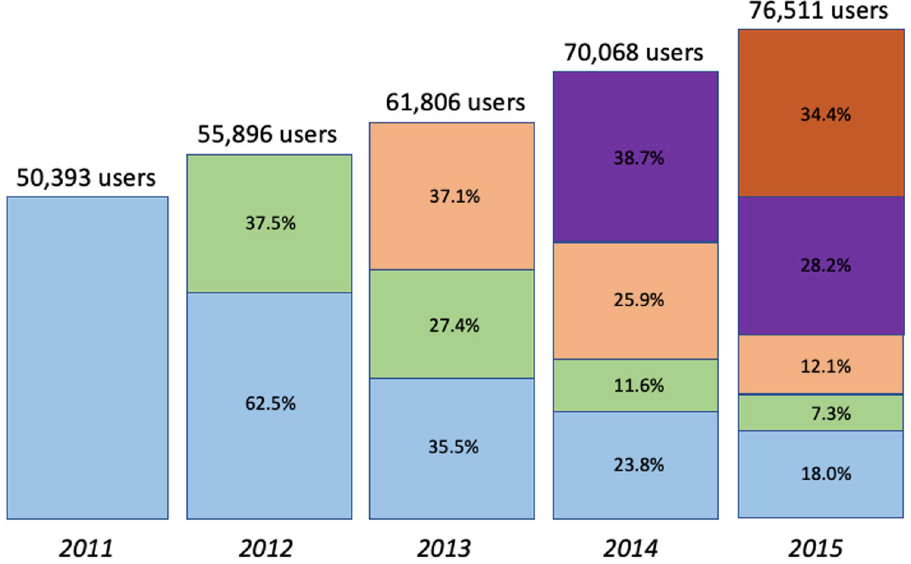
Fig 1. Progressive renewal of users over the years. For each year, the box height represents the total number of users and the colors the year users have entered the system. For example, in 2015, 34.4% of users are new to the system, while 18% started in